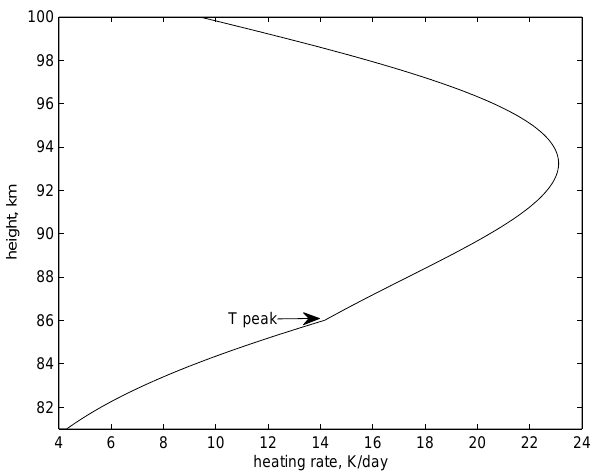
Fig. 9. Height profile of the heating rate calculated with the K ed height distribution from the appropriate TIME-GCM model for TOMEX (Hecht et al., 2004). The altitude of the T peak is shown by the arrow.